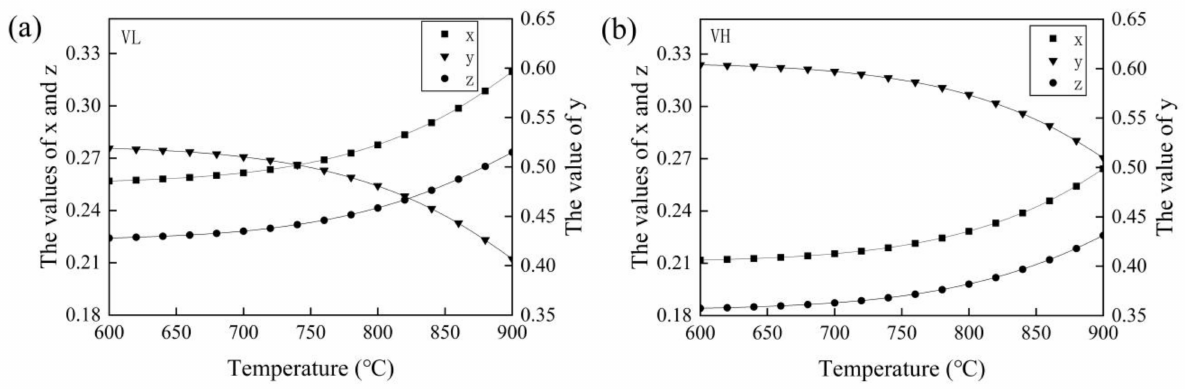
Figure 12. The relationship between the chemical formula coefficients of (Nb x , V y , Ti z ) C precipitated in ferrite and temperature in: ( a ) VL steel; and ( b ) VH